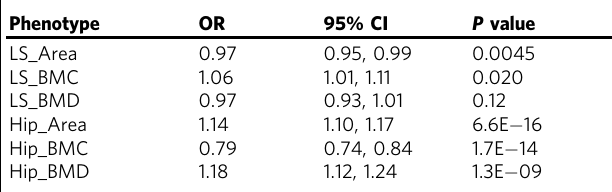
Table 5 Contribution of DXA bone area, BMC and BMD